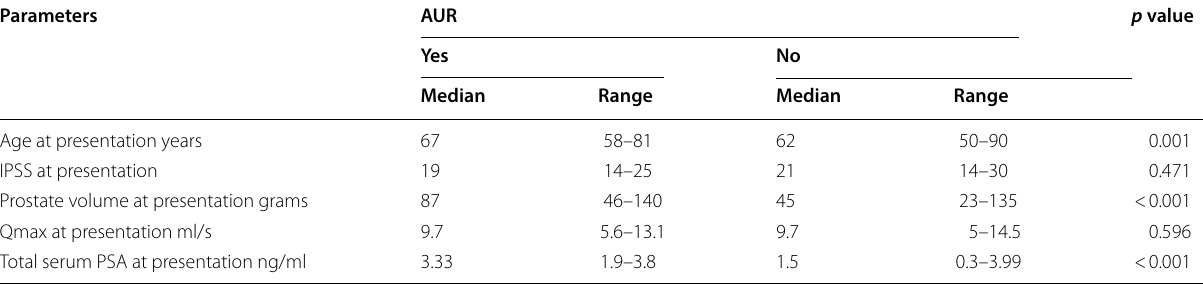
Table 2 Associations between the occurrence of AUR and serum PSA, IPSS, Qmax and prostate volume at initial